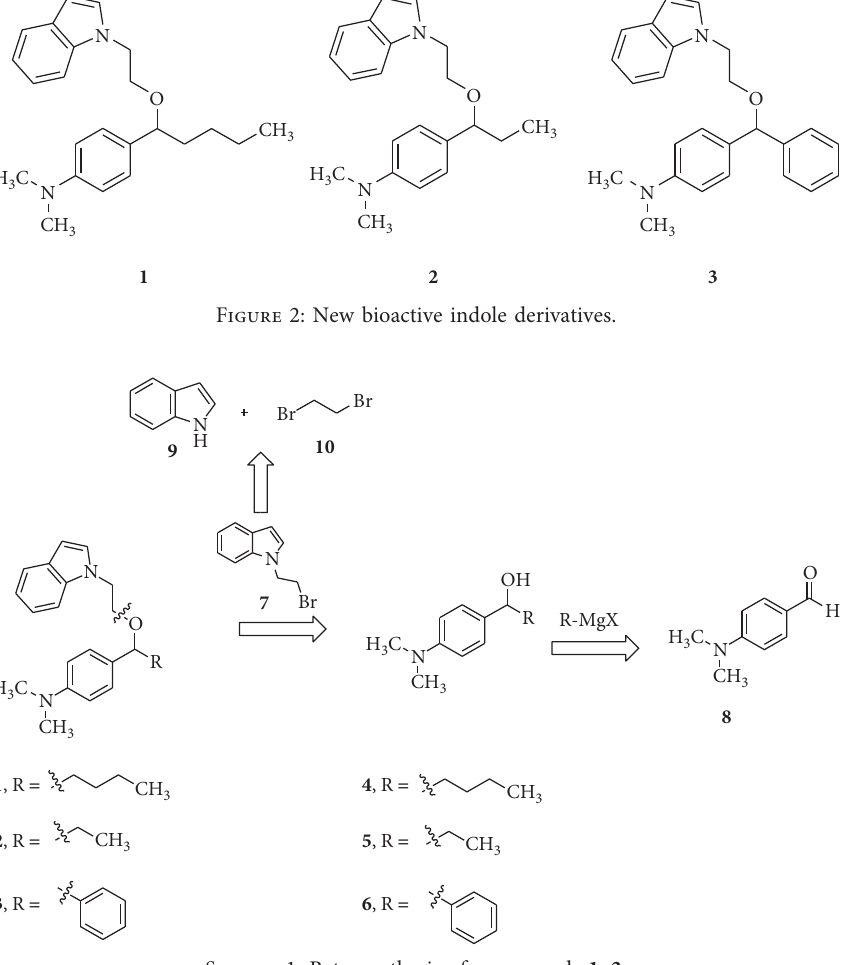
Scheme 1: Retrosynthesis of compounds 1–3